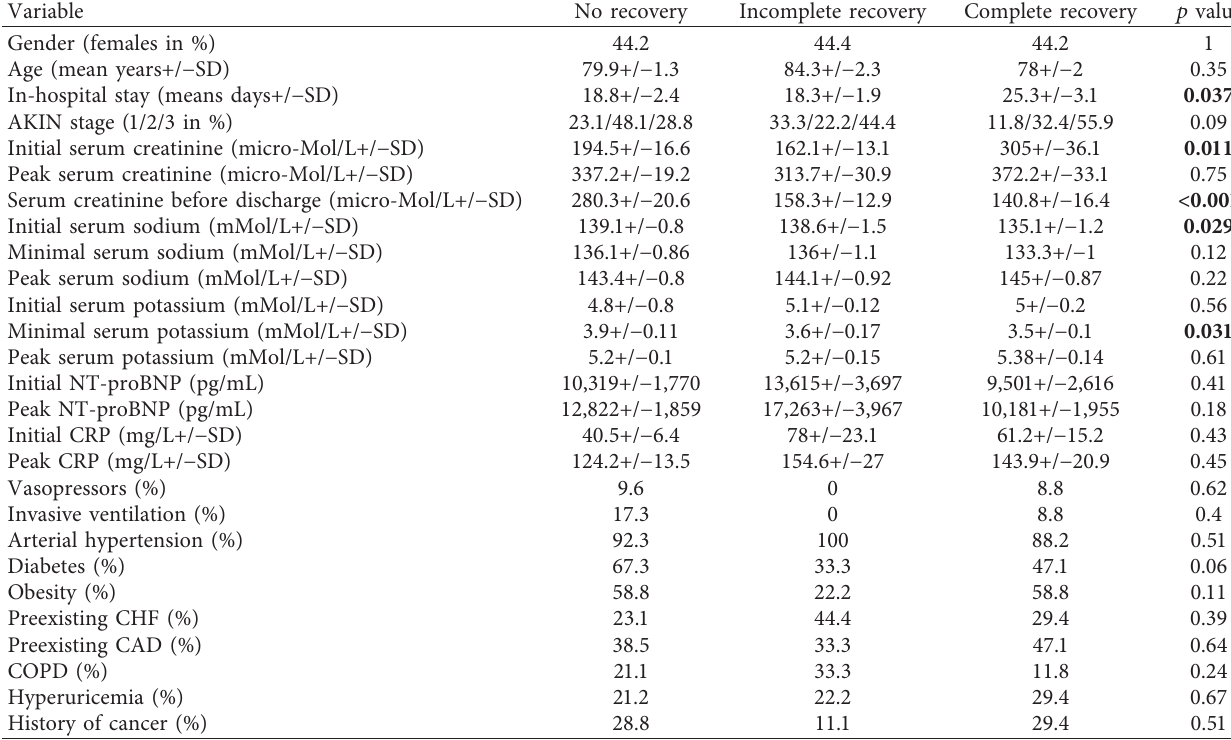
Table 4: Distribution of all variables in subjects without versus with incomplete or complete recovery of kidney function.